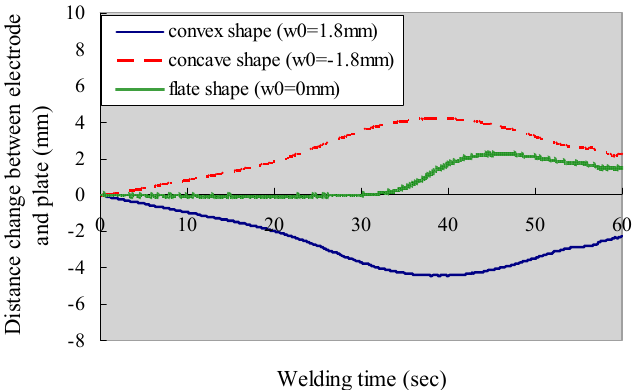
Figure 12. Effect of plate shape on the transient distance change between electrode and plate.